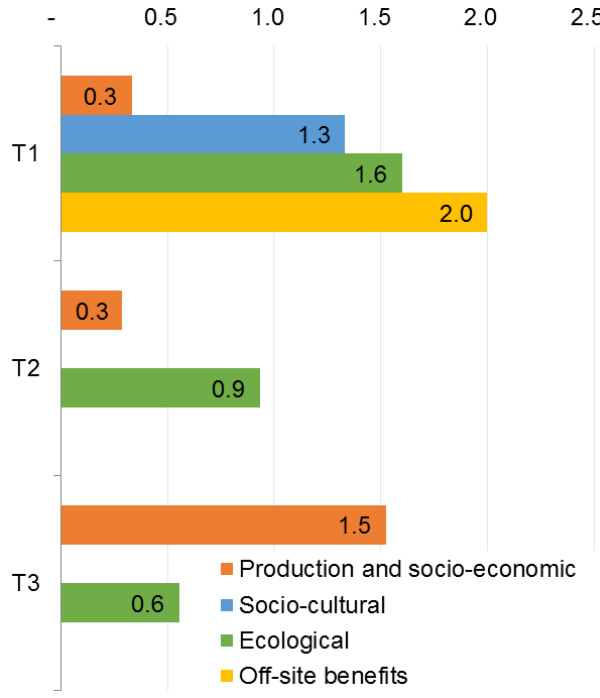
Figure 6. Cumulative score ( S c ) per benefit category for the three technologies